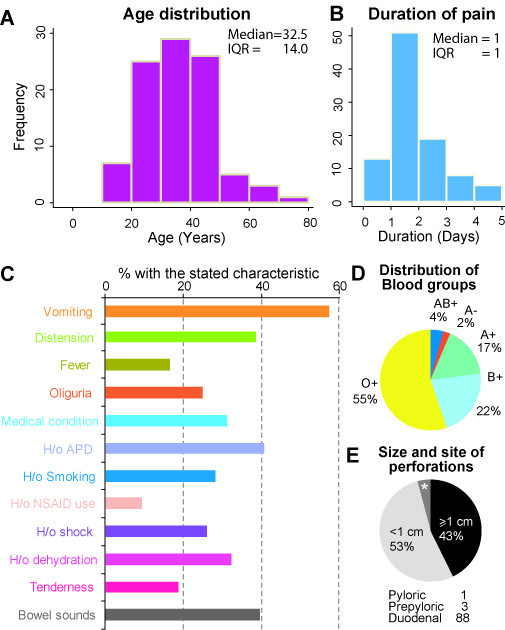
Characteristics of the study subjects. (A and B) Histograms showing the distribution of age (A) and duration of pain (B) in the study subjects. IQR, interquartile range. (C) Bar chart showing the proportion of study subjects with the indicated characteristics on admission. (D and E) Pie chart showing the distribution of blood groups (D) and size of perforation in the study subjects (E). At the bottom of panel E is given the distribution of the site of perforation. * represents the four subjects in which the site of perforation could not be determined intra-opeartively.